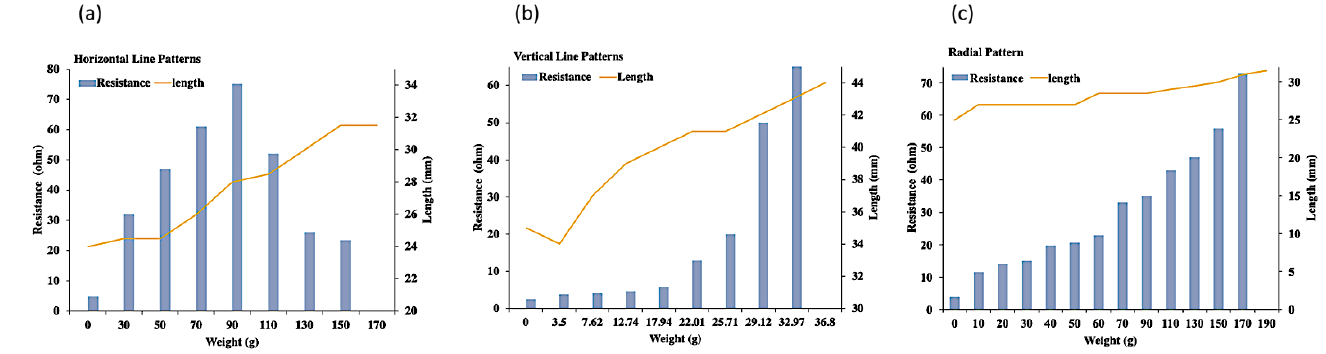
Figure 10. Electrical resistance vs. stretching length of ( a ) horizontal, ( b ) vertical and ( c ) radial pat- terns.